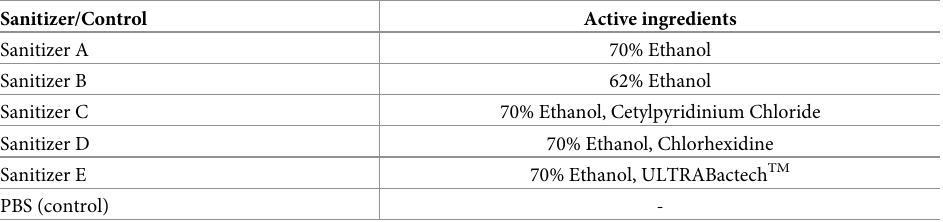
Table 1. List of alcohol-based sanitizers and active ingredients incorporated within the different products. PBS was used as a negative control in the current